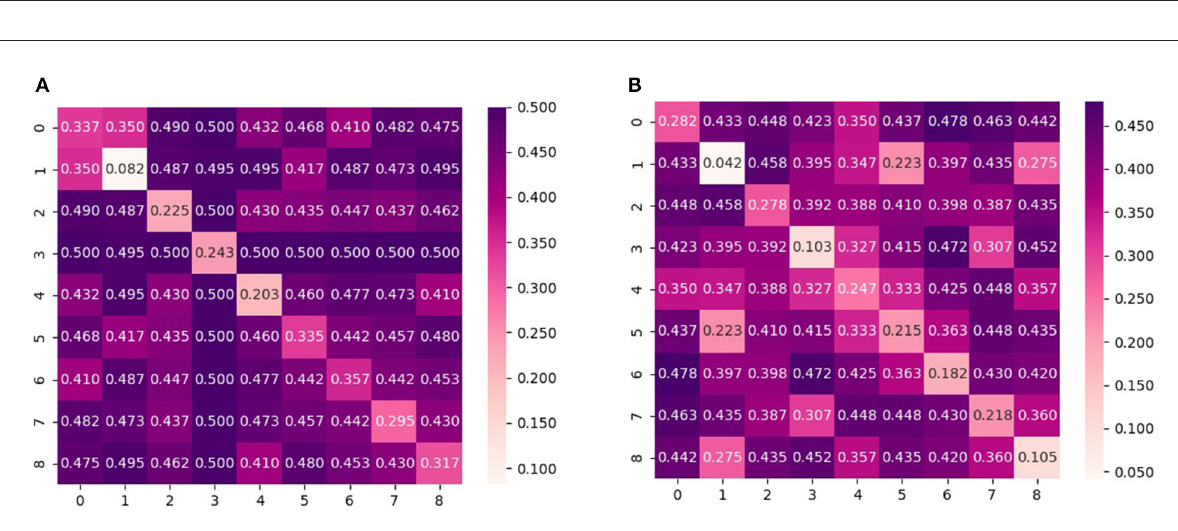
activity with a stationary bike, as reported by Albuquerque et